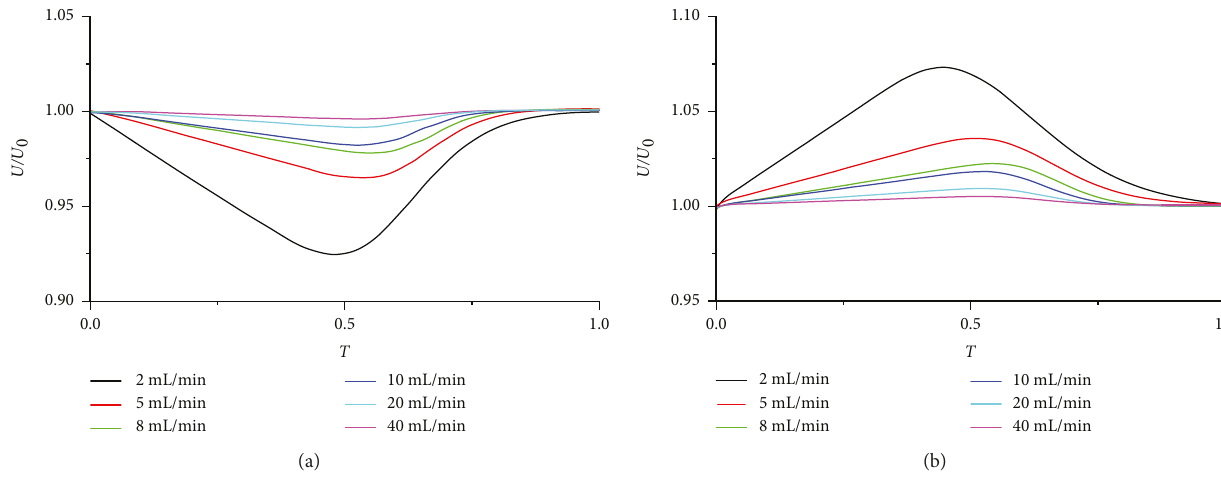
Figure 10: Comparison of fl ow rate at the outlet of each group test: (a) gravity direction and (b) reverse gravity